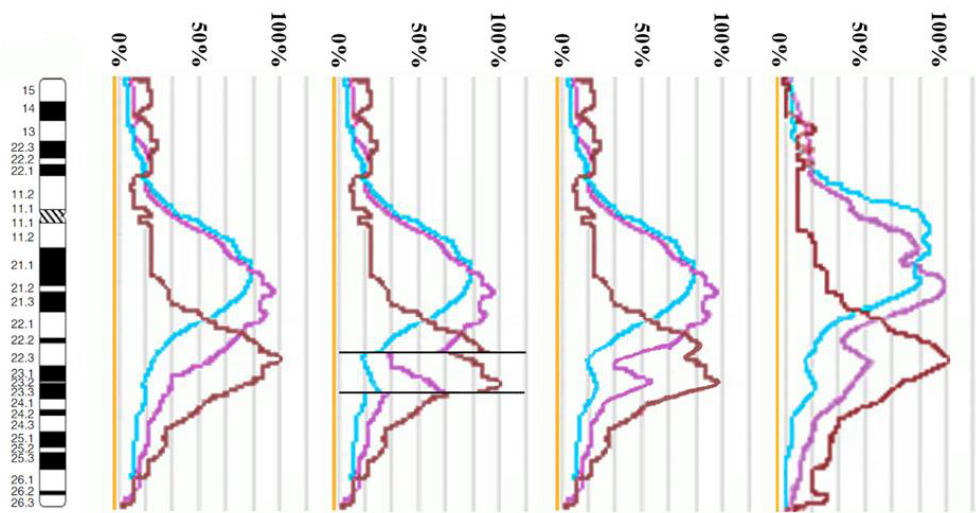
Figure 6. The scheme of hypothetical breakpoints of the inversion in 10q22.2 → q23.3 bands, as pro- posed on the basis of GTG-banding analysis.